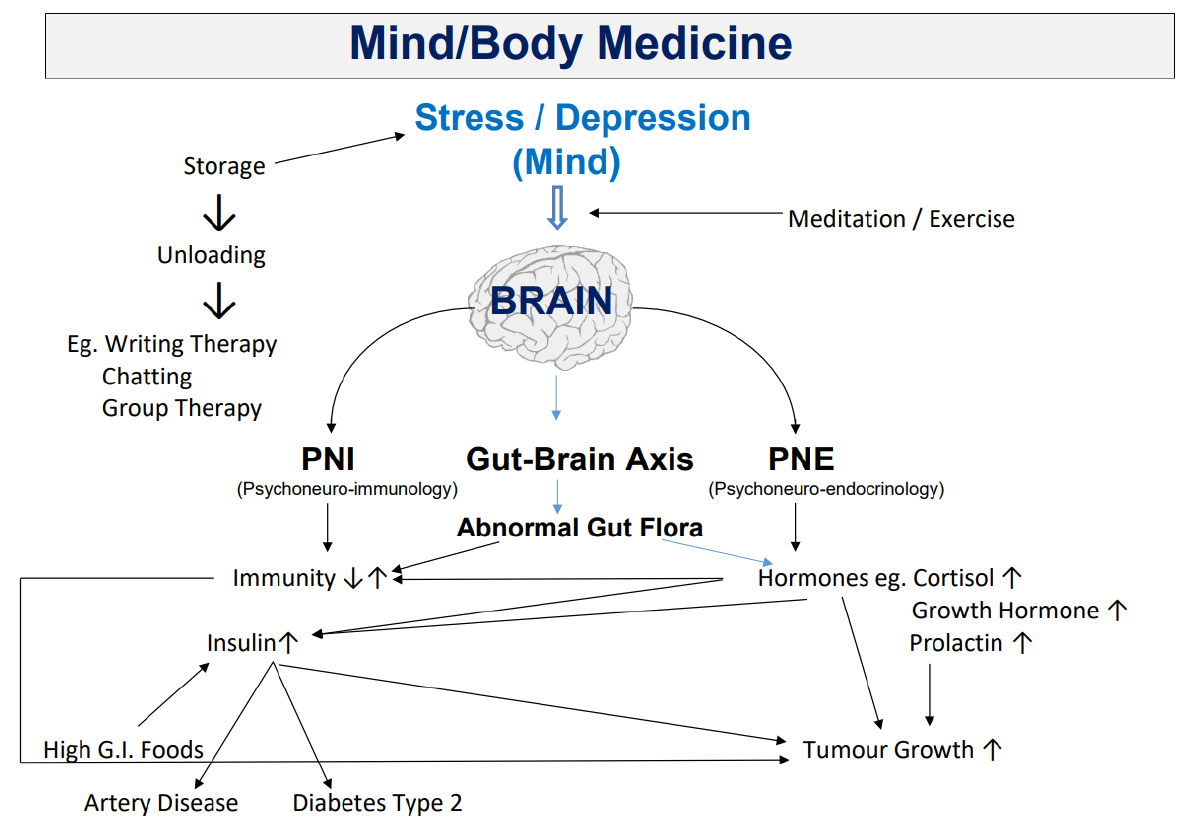
Figure 1. Pathomechanisms by which stress can contribute to cancer (figure reprinted with permission from [13]).